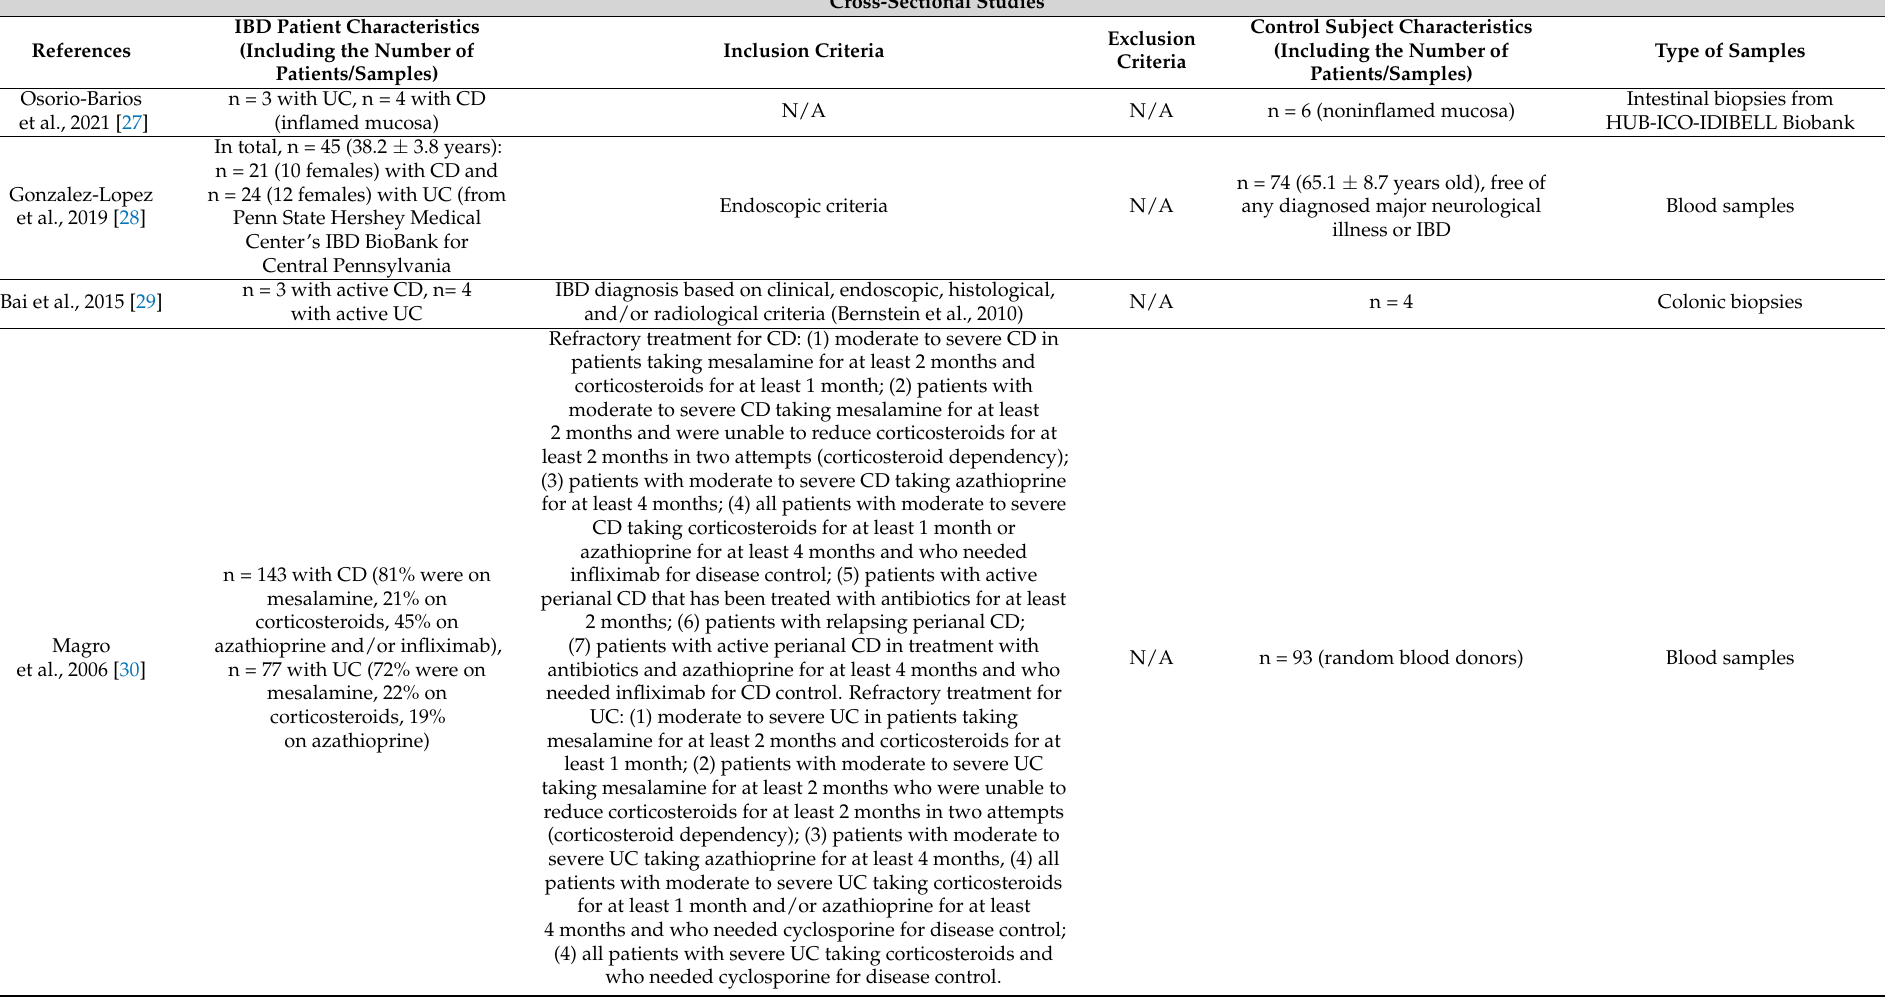
Table 1. Clinical characteristics of the observational studies and case reports included into the analysis. Abbreviations: CD: Crohn’s disease; N/A: not available; UC: ulcerative